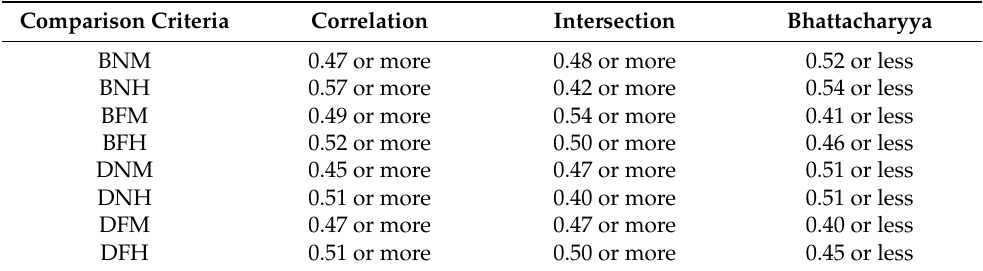
Table 5. Threshold of algorithms according to brightness, perspective, and shooting angle.